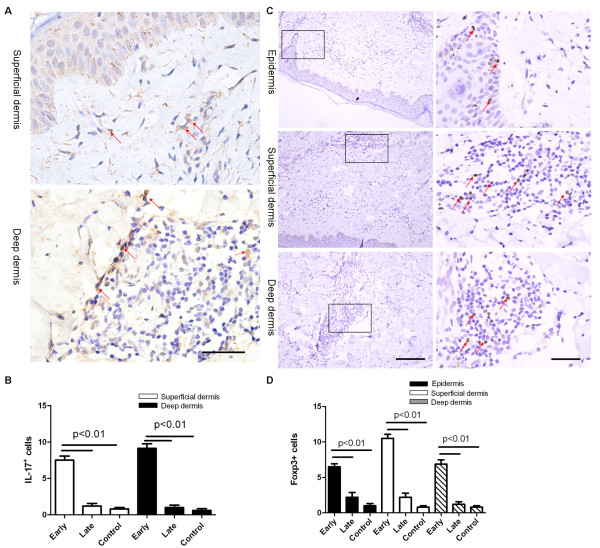
Increased infiltration of IL-17+ and Foxp3+ cells in the skin of patients with active SSc. (A)IL-17 protein expression in superficial dermis and deep dermis of early SSc patients examined by immunohistochemical staining. (B) Counts of IL-17+ lymphocytes in skin of SSc patients (early SSc patients, n = 8; late SSc patients, n = 5). The positive cells in surface were counted under × 400 magnification, and five randomly selected independent microscopic fields were counted for each sample to ensure that the data were representative and homogeneous. (C)Foxp3 protein expression in epidermis, superficial dermis, and deep dermis of patients with early SSc examined with immunohistochemical staining (left panels). Further magnification of the black-bordered box shows typical Foxp3+ lymphocytes (right panels). (D) Counts of Foxp3+ lymphocytes (×400 magnification) in skin of SSc patients (early SSc patients, n = 8; late SSc patients, n = 5). The positive cells in surface were counted under × 400 magnification, and five randomly selected independent microscopic fields were counted for each sample to ensure that the data were representative and homogeneous. Scale bar, 100 μm.